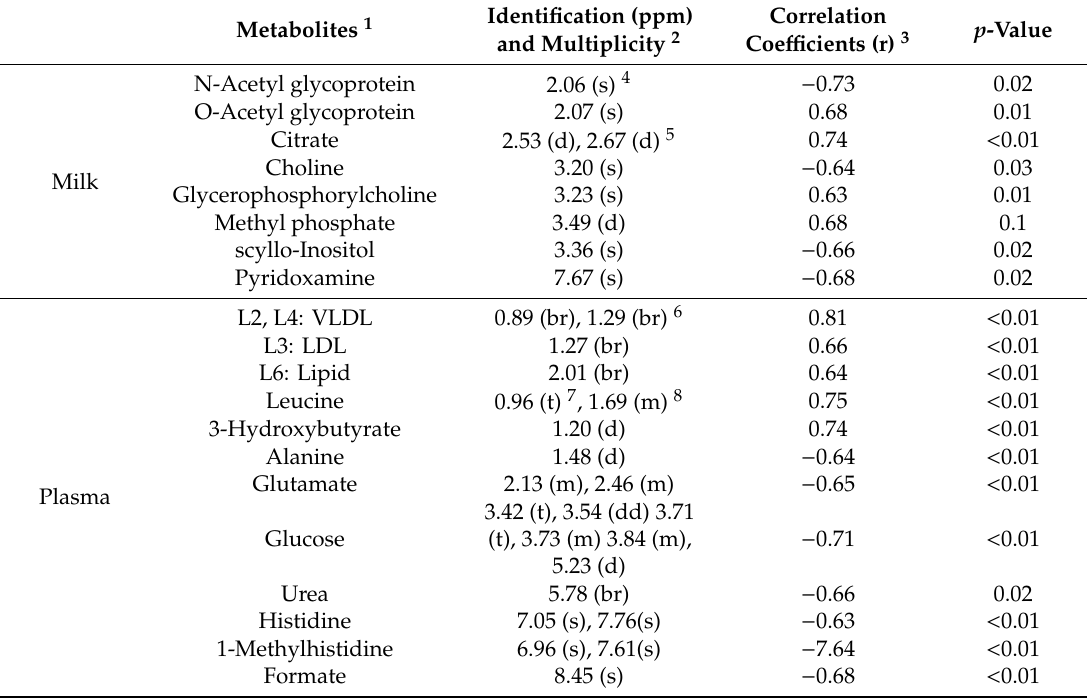
Table 4. OPLS-DA coefficients derived from the 1 H NMR data of metabolites in the milk and plasma of cows reared in the heat stress and thermoneutral zone.